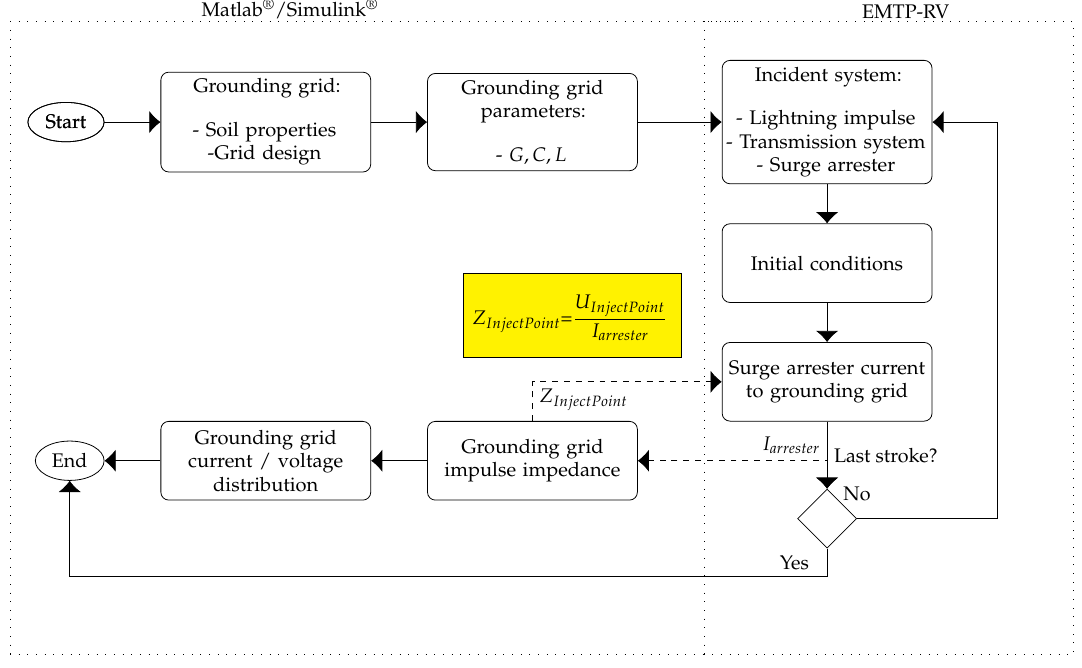
Figure 5. Schematic overview of the integration between grounding and transmission system.